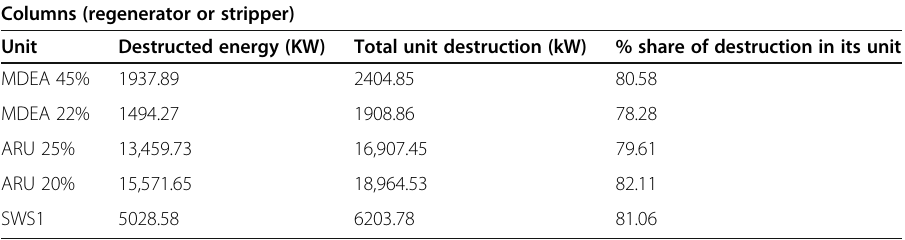
Table 11 Comparison between columns destructions in three units Columns (regenerator or